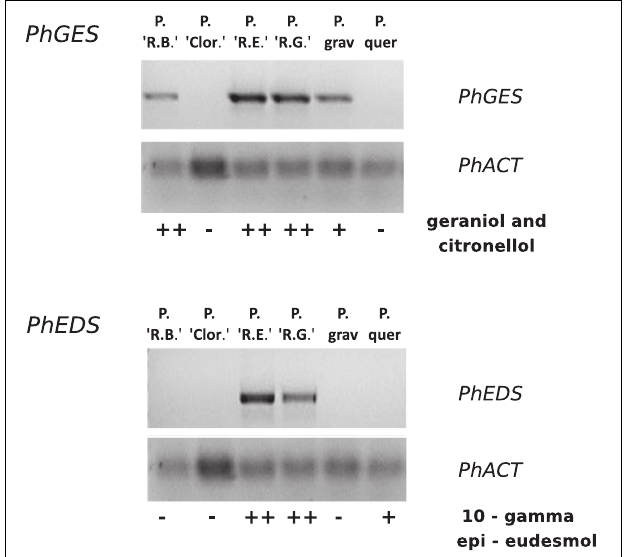
FIGURE 6 | Semi-quantitative RT-PCR analysis of PhGES and PhEDS in several pelargonium species. PhACT is used as a reference gene. Abundance of terpenes related to the expression of each gene is depicted in the lower lane after Table 1